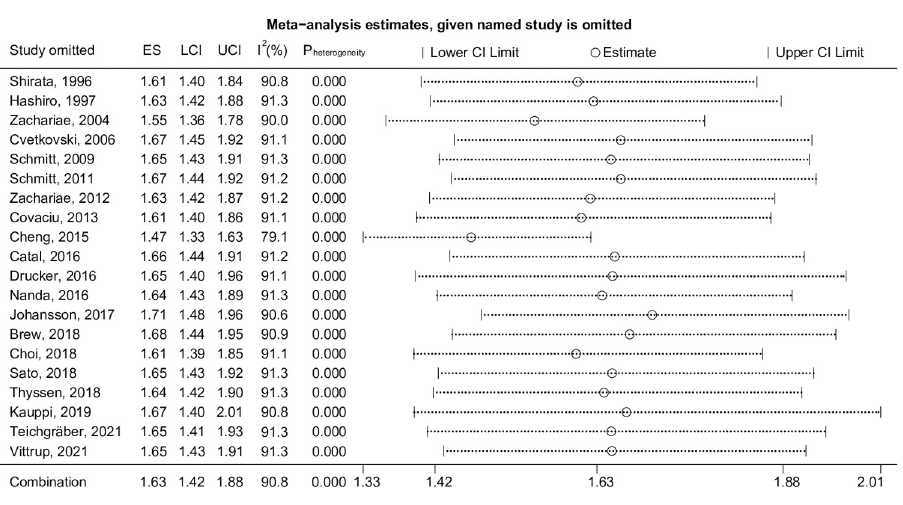
PLOS ONE | https://doi.org/10.1371/journal.pone.0263334 February 18,